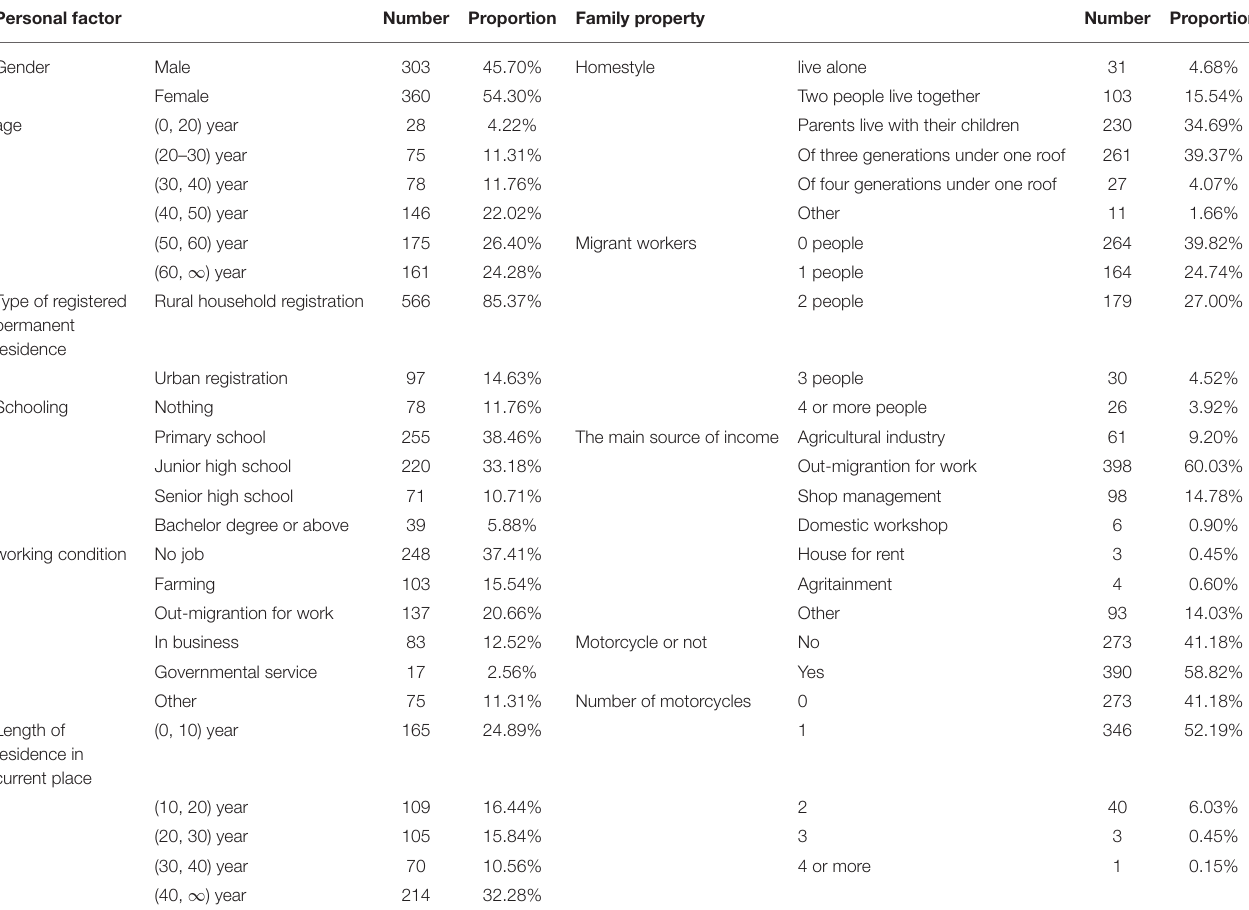
TABLE 2 | Social demographic